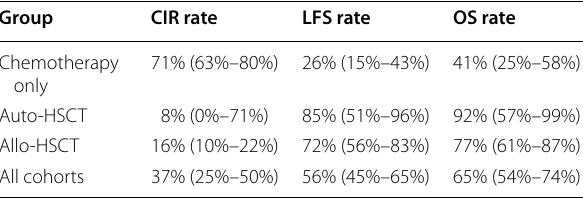
CIR cumulative incidence of relapse, LFS leukemia-free survival, OS overall survival, allo-HSCT allogeneic hematopoietic stem cell transplantation, auto- HSCT autologous-hematopoietic stem cell transplantation